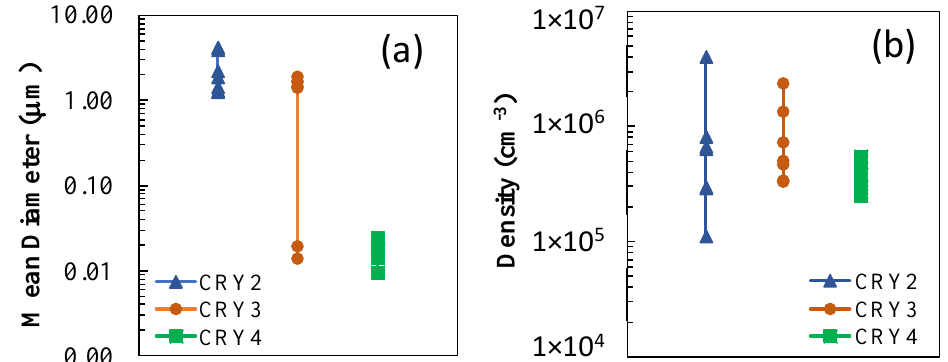
Figure 7. Te inclusions, ( a ) size and ( b ) density for samples from different positions in CdTe:Cl ingots. A comparison plot for Cl-doped samples shown in Figure 7 indicates that the average size and density of Te inclusions is slightly decreasing with the increasing weight %